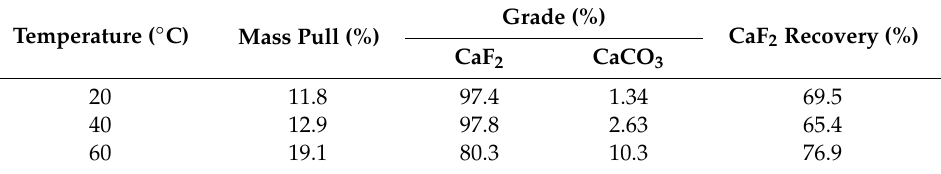
Table 5. E ff ect of temperature on mass pull and gangue (calcite)